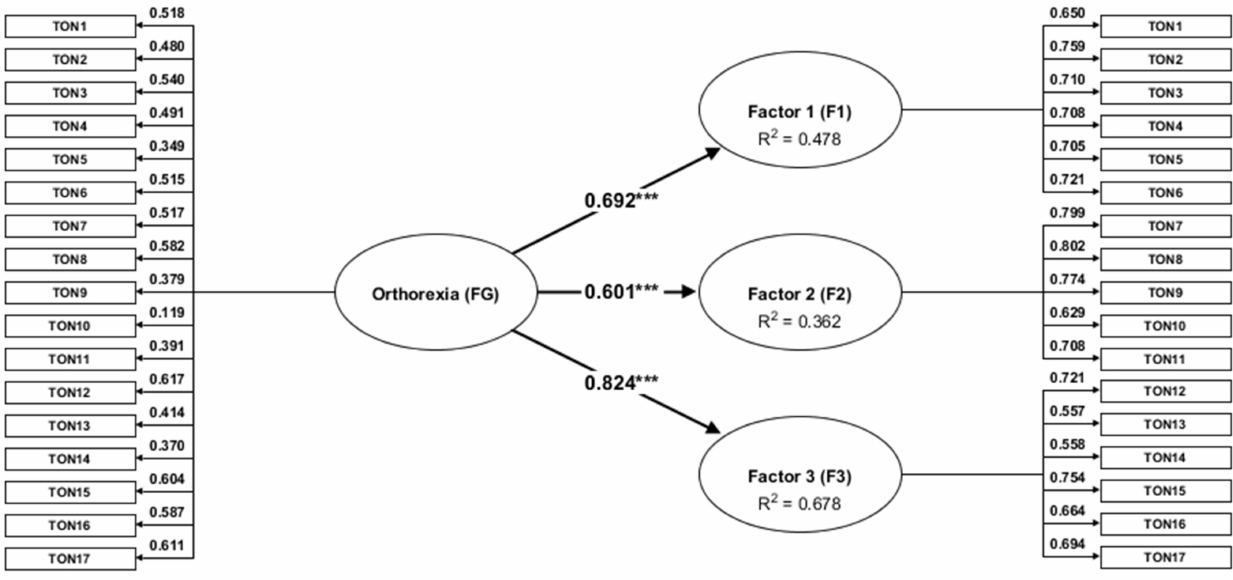
Figure 2. Orthorexia bi-factor reflective model. *** p <